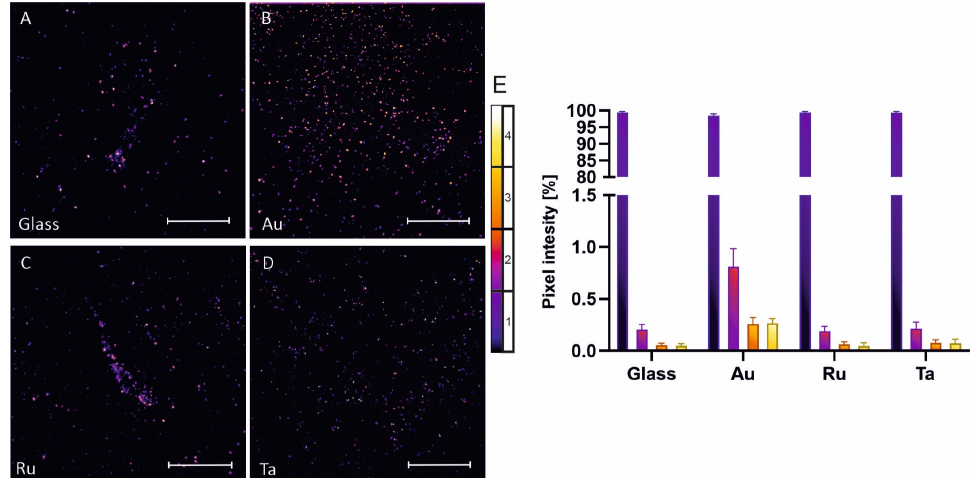
Figure 7. ROS assay of Pseudomonas aeruginosa grown for 24 h on glass, gold, ruthenium and tantalum surfaces. Reactive oxygen species were measured with the help of 2-7-dichlorofluorescin diacetate assay. Images were obtained by confocal laser scanning microscopy and are presented as false color images, using a fire ice false color coding ( A – D ). Highest intensity is depicted as yellow white and darkest pixels are shown as black blue. Most pixel values are in the background range (0–63 black blue) ( E ), while gold shows the highest amount of ROS production (orange and yellow